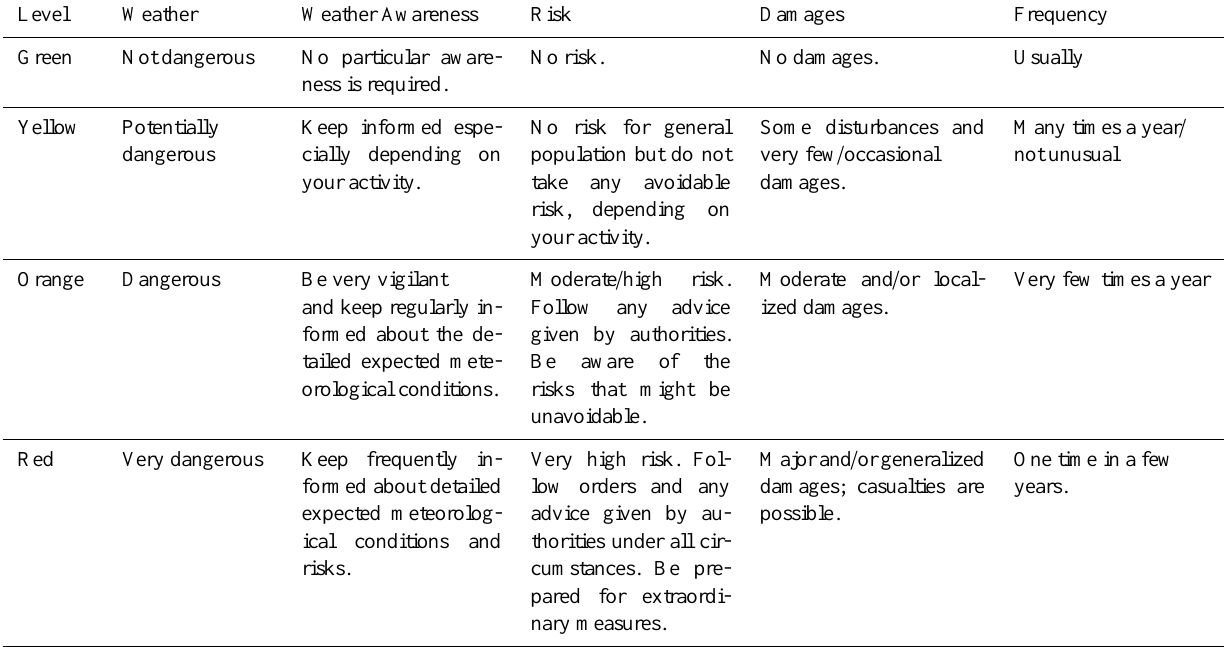
Many times a year / not unusual Very few times a year